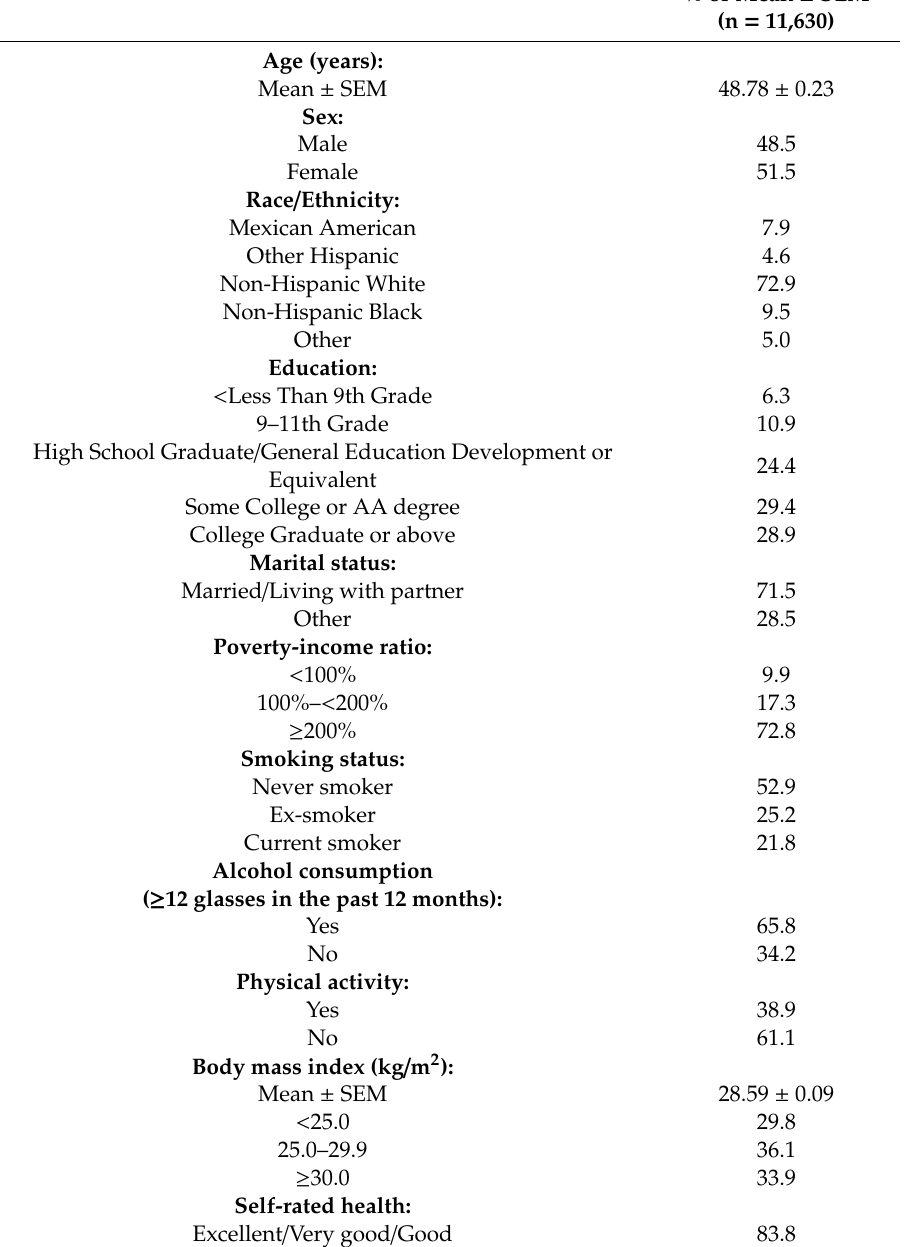
Table 1. Baseline characteristics—2001–2010 NHANES (n =